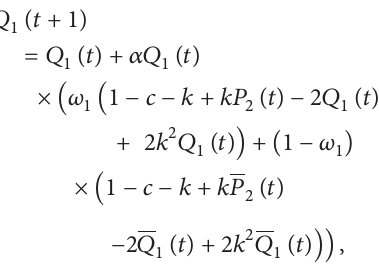
bad for the economy. We also find that the adjustable range of 𝛼 is larger than that of 𝛽 , which means that the adjustment of price is more sensitive than that of output, and price war will be easier to get market into